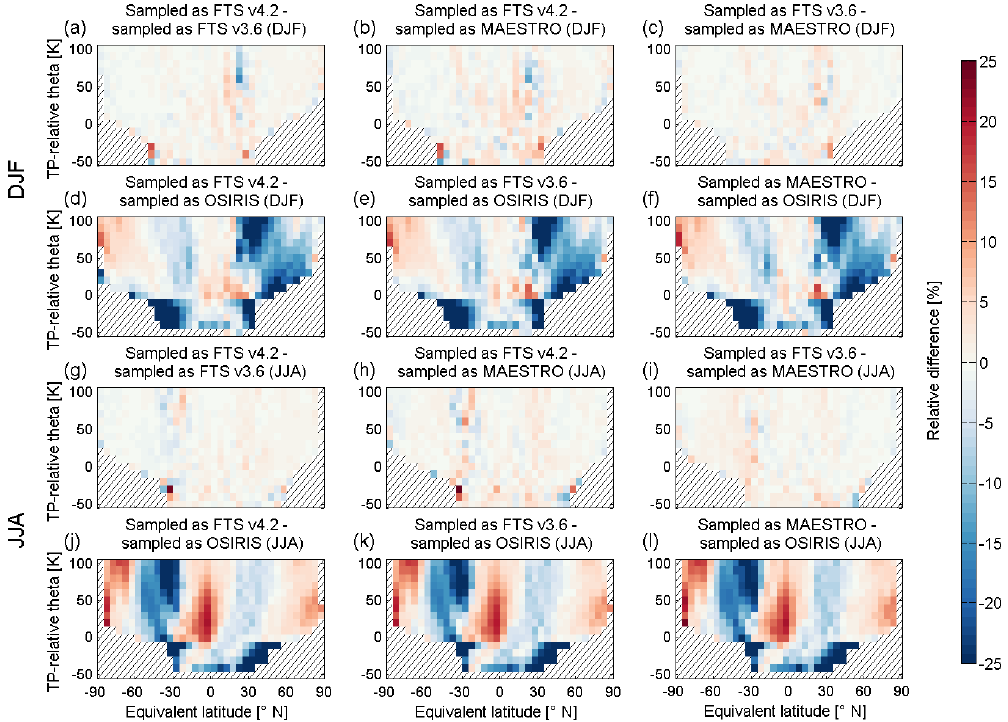
Figure 6. Same as Fig. 3 but for ozone and including an additional two rows for comparisons involving climatologies constructed from the OSIRIS measurement pattern. Note that the DJF and JJA comparisons are now spread over two rows each, with the top two rows corresponding to the former and the bottom two to the